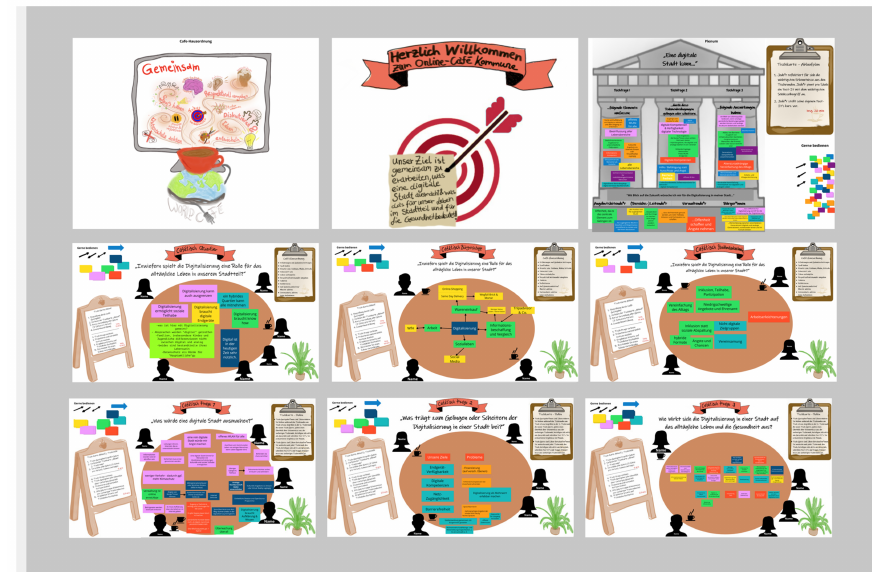
Figure A2. Labelled digital pinboard after the online World Caf é